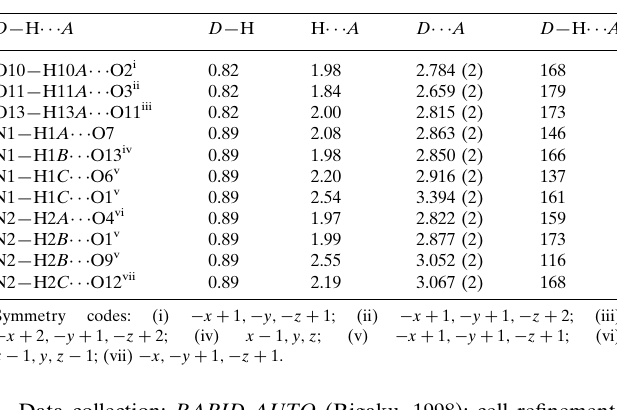
Hydrogen-bond geometry (A˚ , (cid:3)